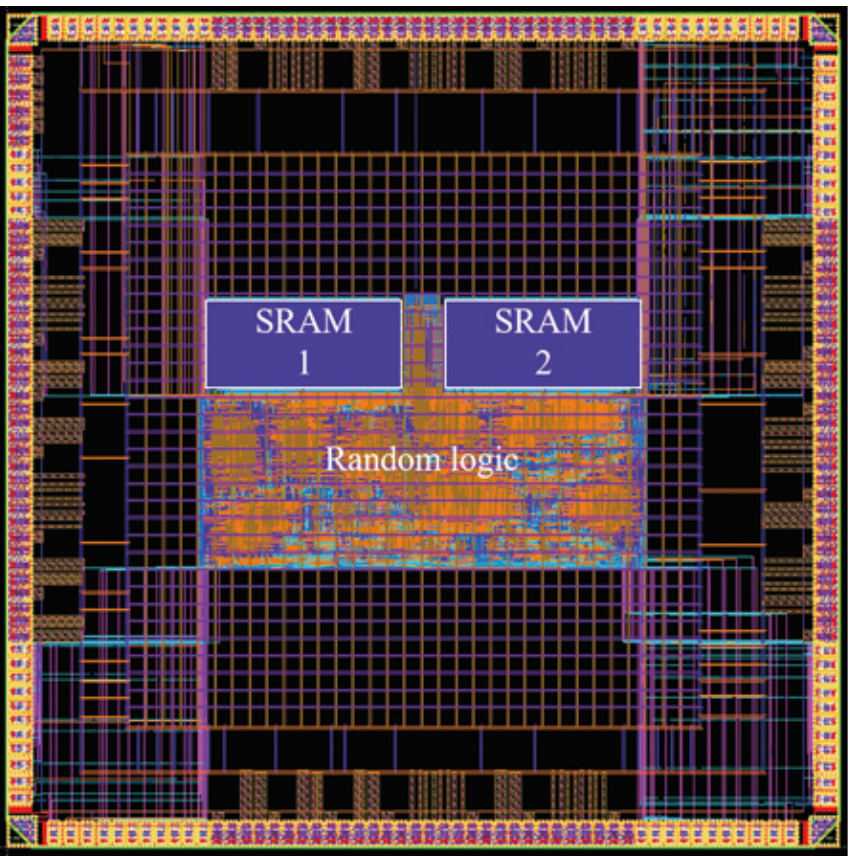
Figure 12. The layout of the watermarking